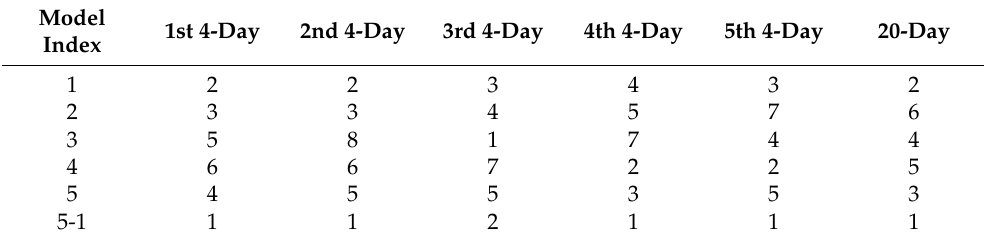
Table 4. Segmental and overall rankings of the 5-in-1 (ensemble) and top five WRF models as determined using the 20-day wind speed training